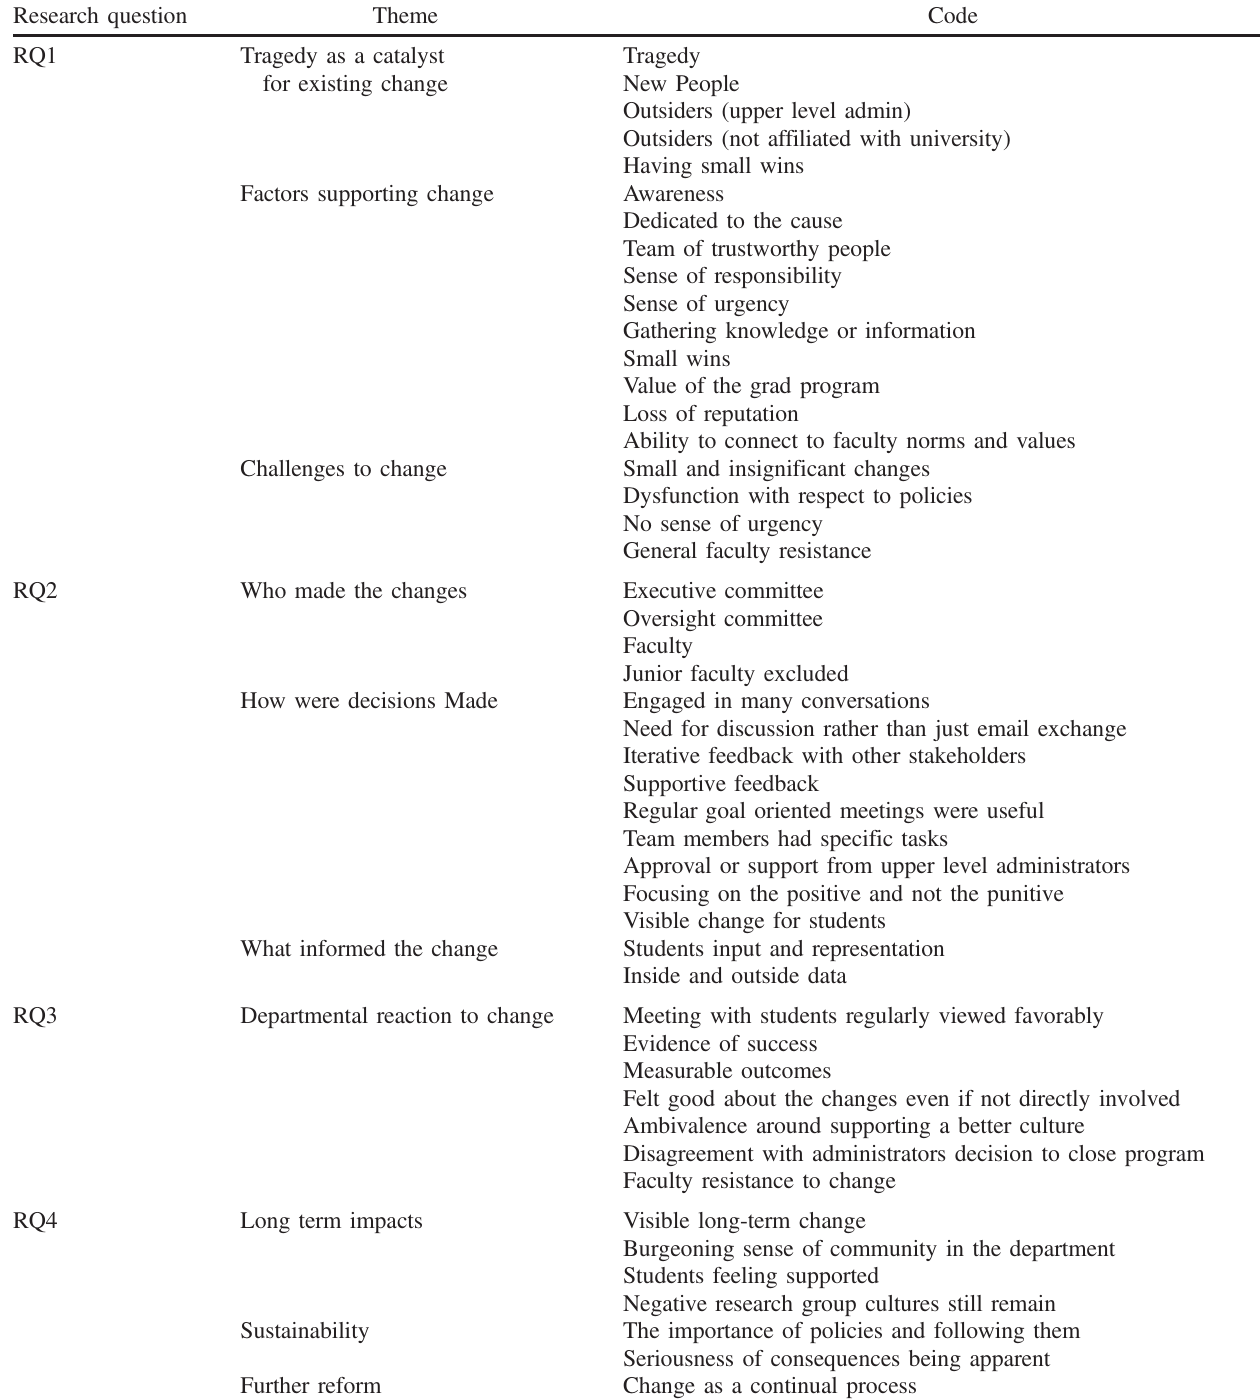
TABLE I. Codebook organized by research question, then themes, then individual codes. Research